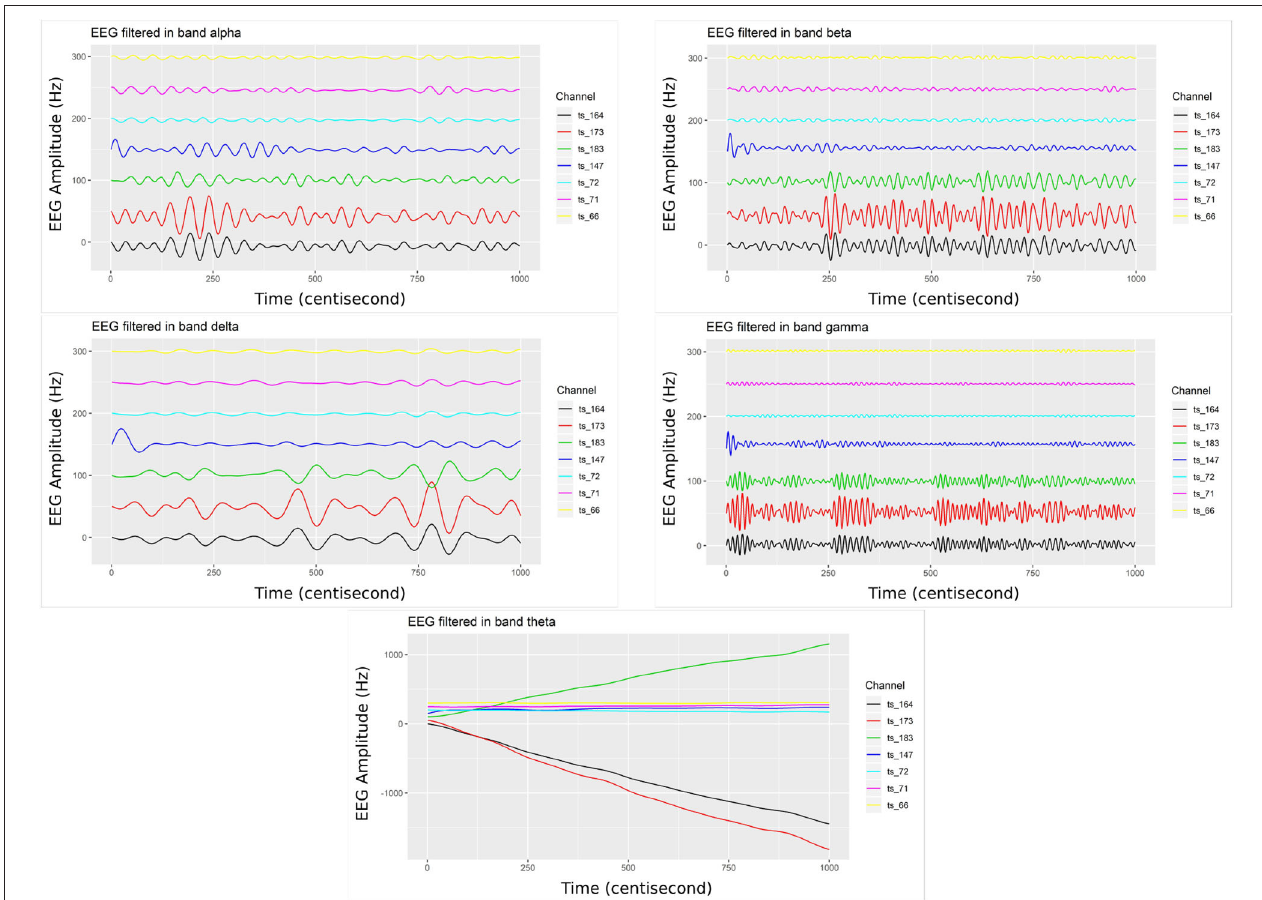
FIGURE 5 | Bandpower from the filtered EEG signals (top left) considering the alpha band, (top right) filter in the beta band, (middle left) in the delta band, (middle right) in the gamma band, and (bottom center) filter in the theta band. The EEG electrodes placed on the right-side brain hemisphere present higher dynamic/variation (channels 164, 173, and 183), related to post-2 mA stimulation.